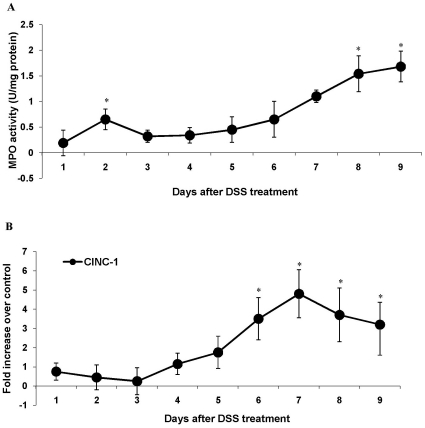
The effect of DSS treatment on the expression and activity of pro-inflammatory mediators.
A: Myeloperoxidase activity (MPO) was measured in the colonic mucosa of rats administered 5% DSS in drinking water for 1–9 days. MPO activity is expressed as unit per mg tissue and all values are the means ± SEM of 6 animals/day. *P<0.05 compared with normal control groups. B: The effect of DSS treatment on CINC expressions. The relative gene expression levels were determined by real time PCR for CINC gene using mRNA extracted from control and DSS treated rats during 9 days of DSS treatment. Expression levels of all genes were normalized using GAPDH as housekeeping gene. The mRNA levels are plotted as fold change over control. Data shown are the means ± SEM of 6-animals/day. *P<0.05 and **P<0.001 compared to control colon.